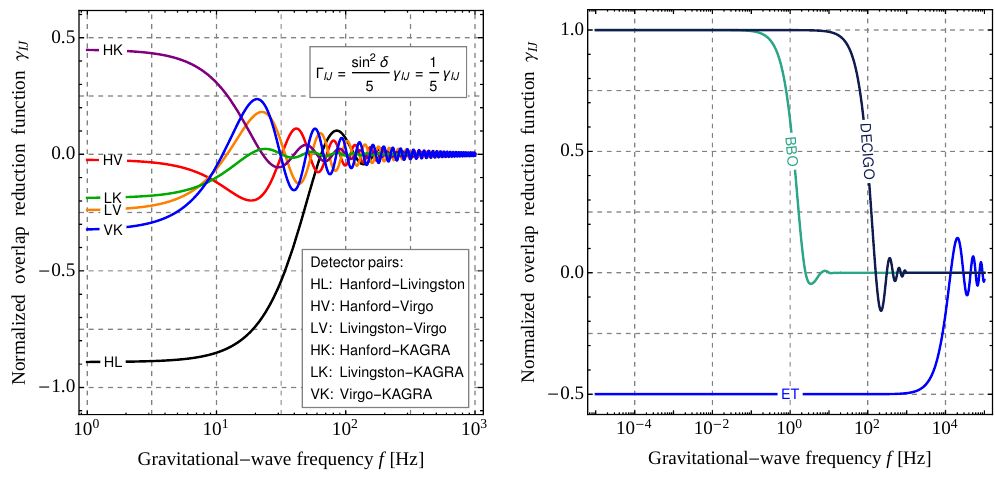
Figure 11 . Overlap reduction functions for pairs of L-shaped (left) and triangular (right)